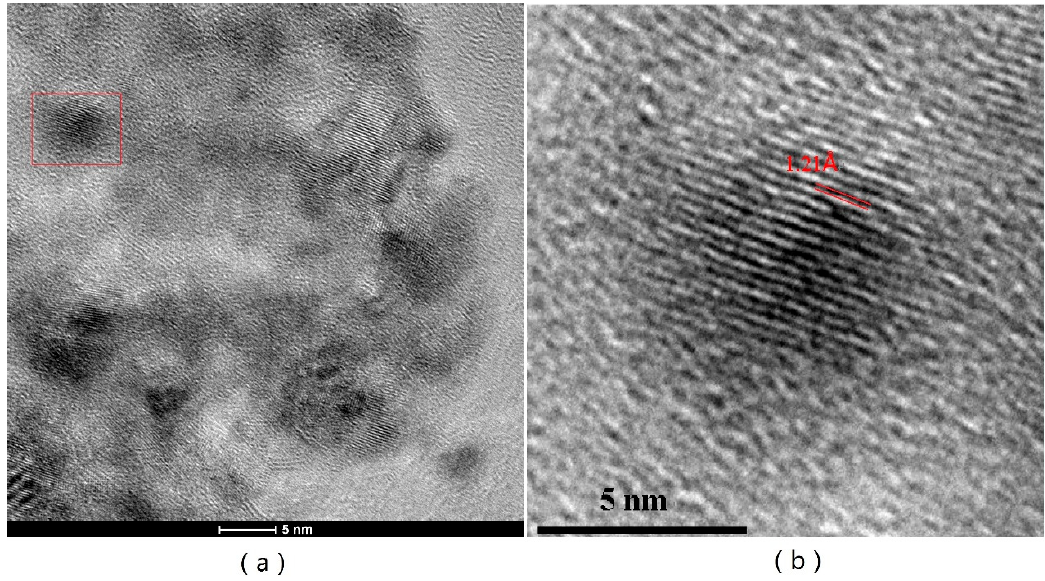
Figure 5. ( a ) High-Magnification Transmission Electron Microscope (HRTEM) of the CNMA-4 sample reduced with H 2 at 300 °C for 2 h; ( b ) the image of HRTEM for a single particle from (a).